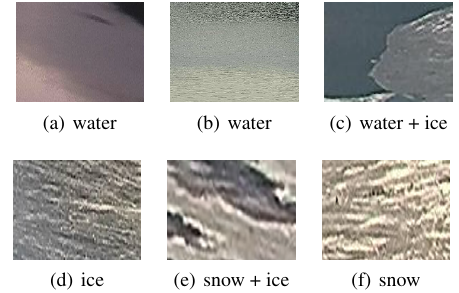
Figure 2: Texture variability of water, ice, and snow in the Photi-LakeIce